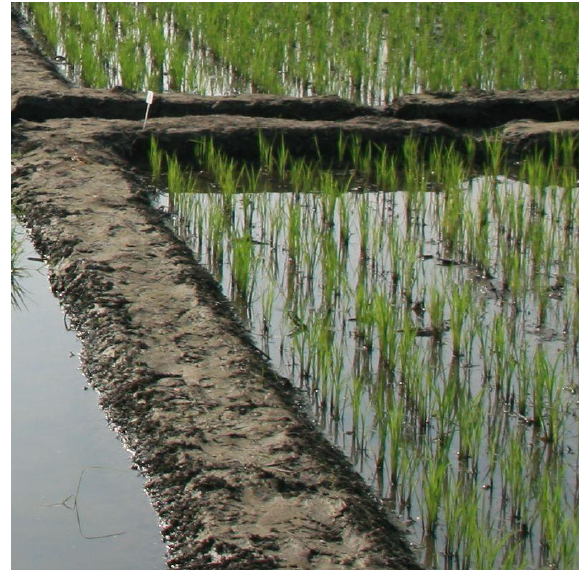
Figure 2. Photo of one corner of the investigated field, showing the least dense